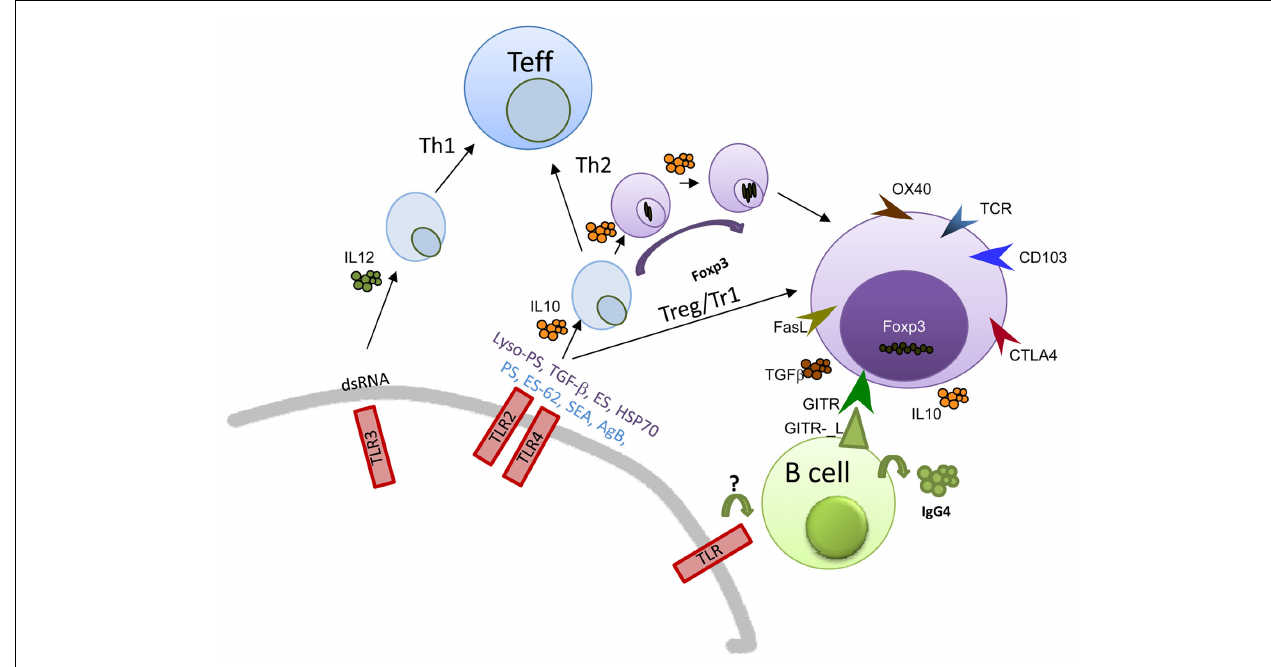
or 4 and some have been described to induceTreg.The ensuingTreg population is distinguished by their display of distinct markers such as GITR and CTLA-4. IL-10-producingTreg have been shown to promote IgG4 production by B cells and in vitro this was found to be dependent on IL-10, TGF- β , and GITR–GITR-L interaction.These non-inflammatory scenarios would be beneficial during helminth infections since they would control excessive immune